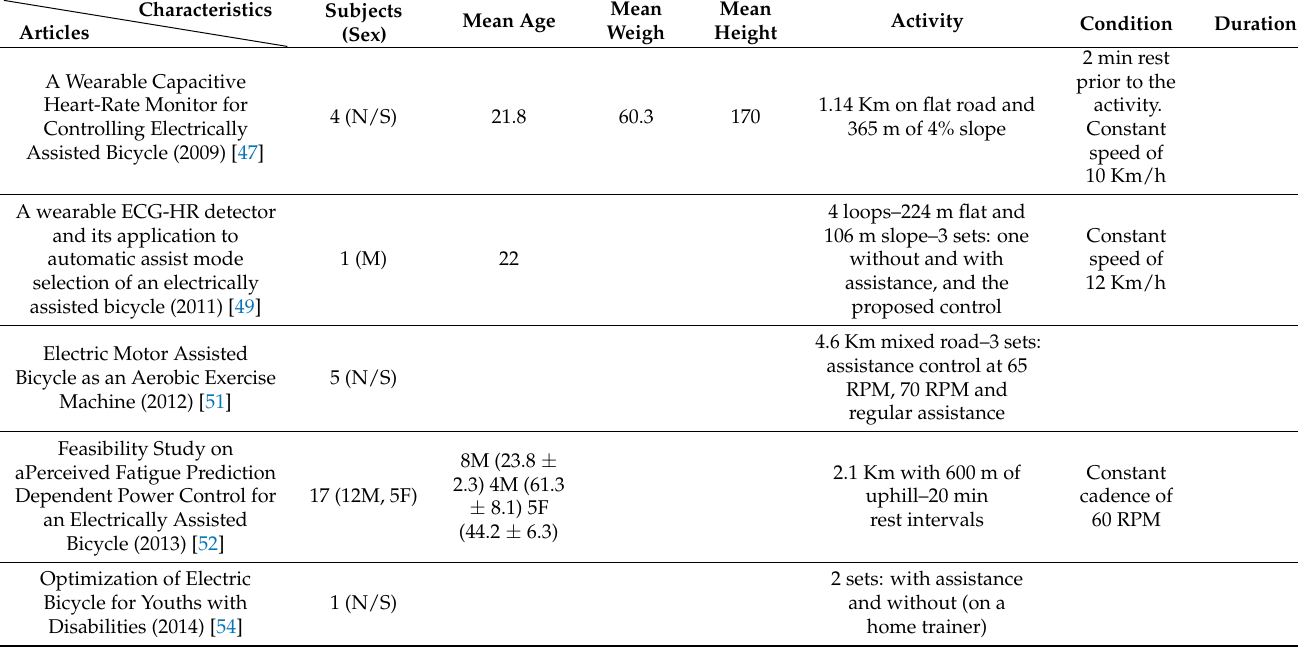
Table 3. Study characteristics across the